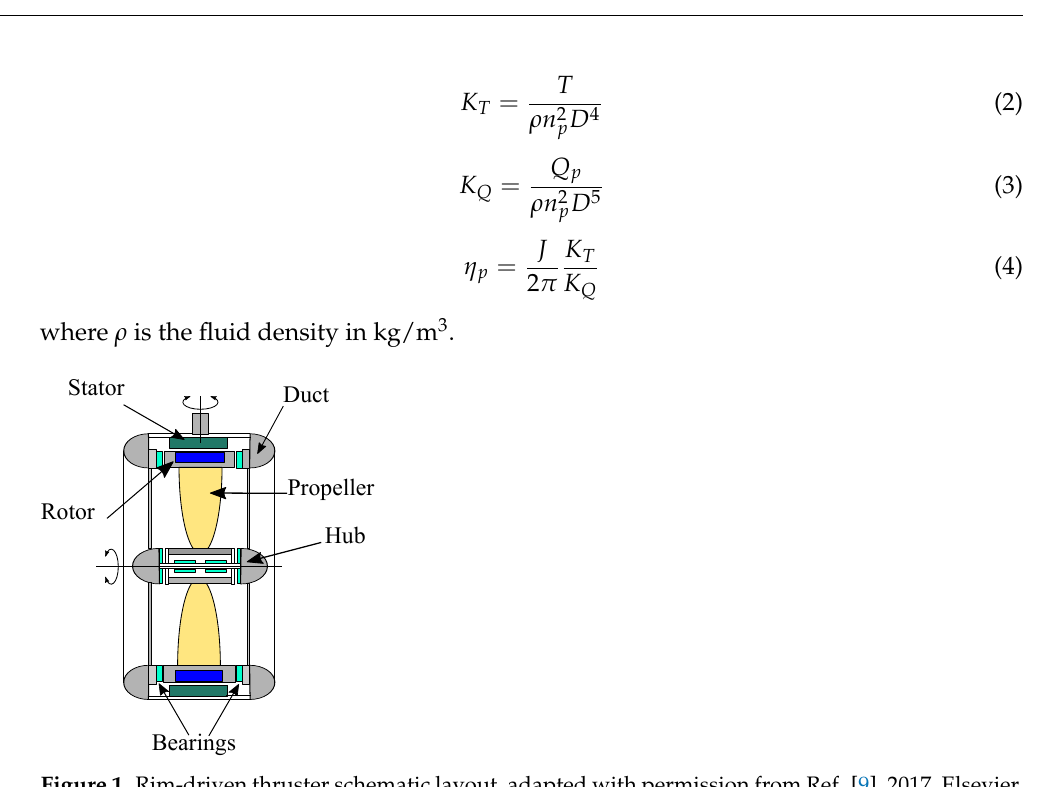
Figure 1. Rim-driven thruster schematic layout, adapted with permission from Ref. [9], 2017, Elsevier.